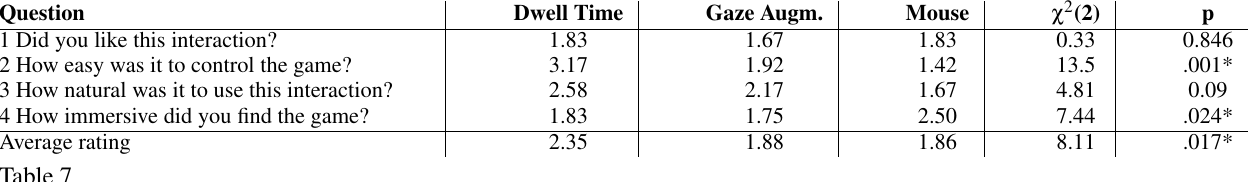
The summary of the user experience questionnaire. Lower number means better result. using only half the number of moves than participants in the mouse condition, and only one-third of the number of moves than the participants in the dwell-time condition. This would indicate that most of the problem-solving activities occurred internally and participants had to use more planning activities on the internal representation of the problem before invoking a change in the external